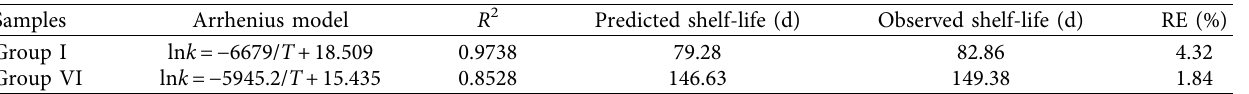
Table 3: The Arrhenius model parameters, predicted shelf-life, observed shelf-life, and RE of peanut oil with addition of Group I or Group VI antioxidant compounds.